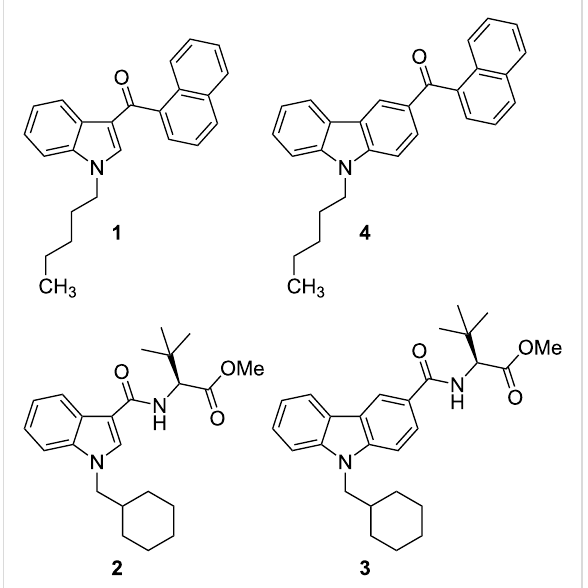
Figure 1: Synthetic cannabinoids JWH-018 ( 1 ), MDMB-CHMICA ( 2 ), MDMB-CHMCZCA ( 3 ), and EG-018 ( 4 ).